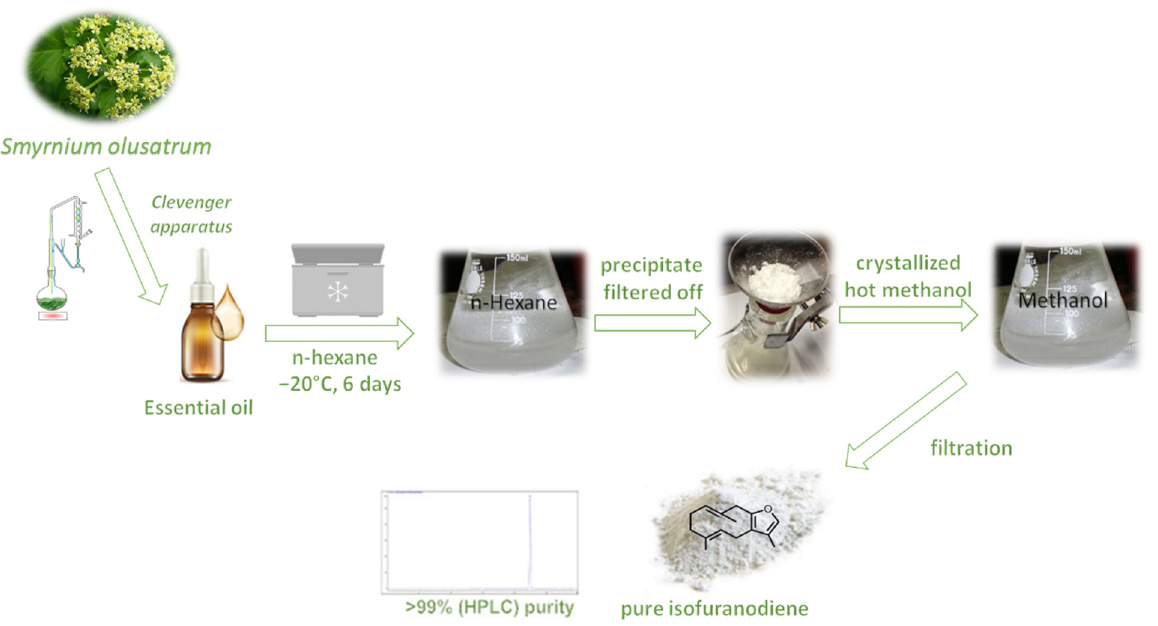
Figure 4. Isolation and purification of isofuranodiene.